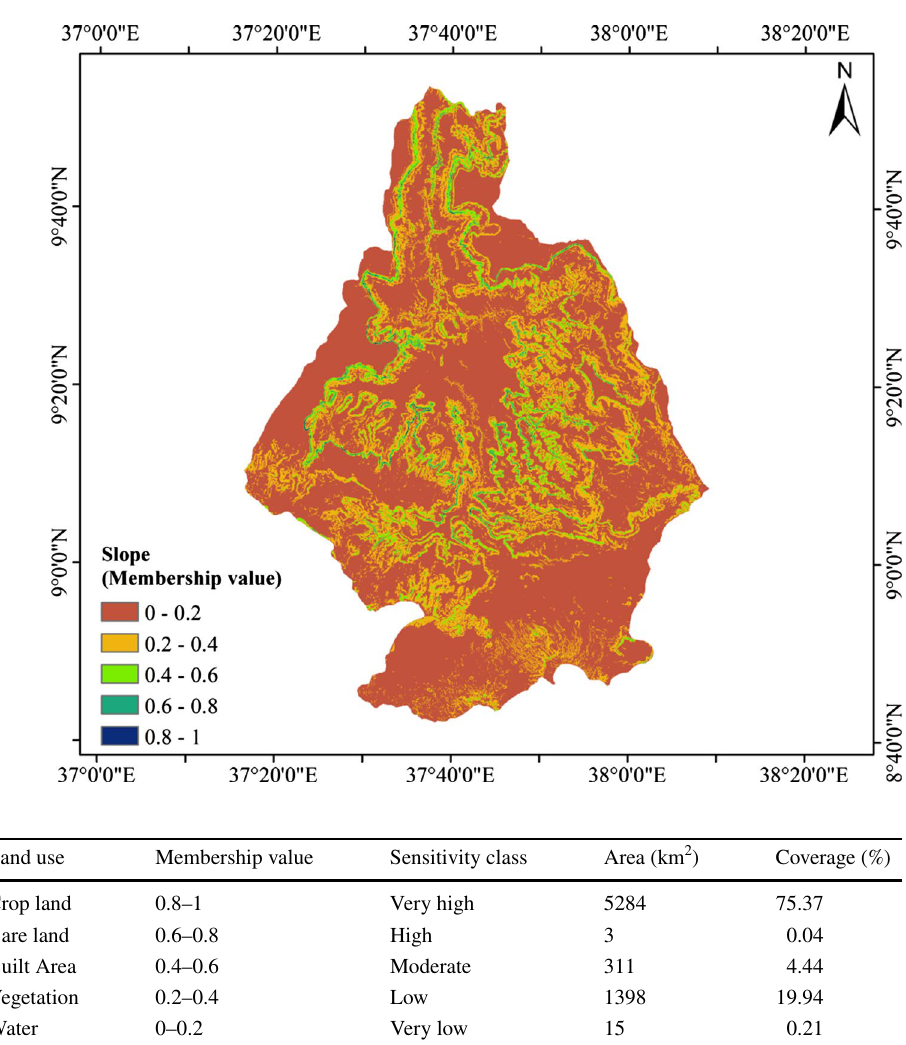
Fig. 7 Fuzzy membership value of slope classes